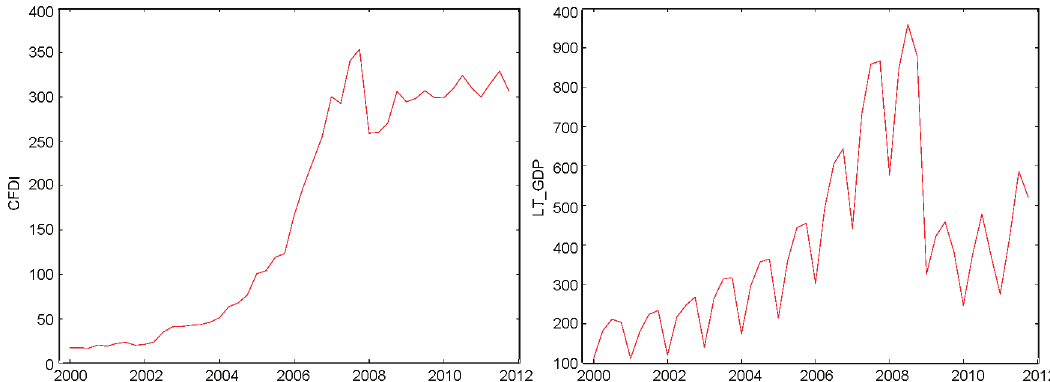
Fig. 4. Time series plots of Lithuania’s CFDI and the construction’s contribution to GDP